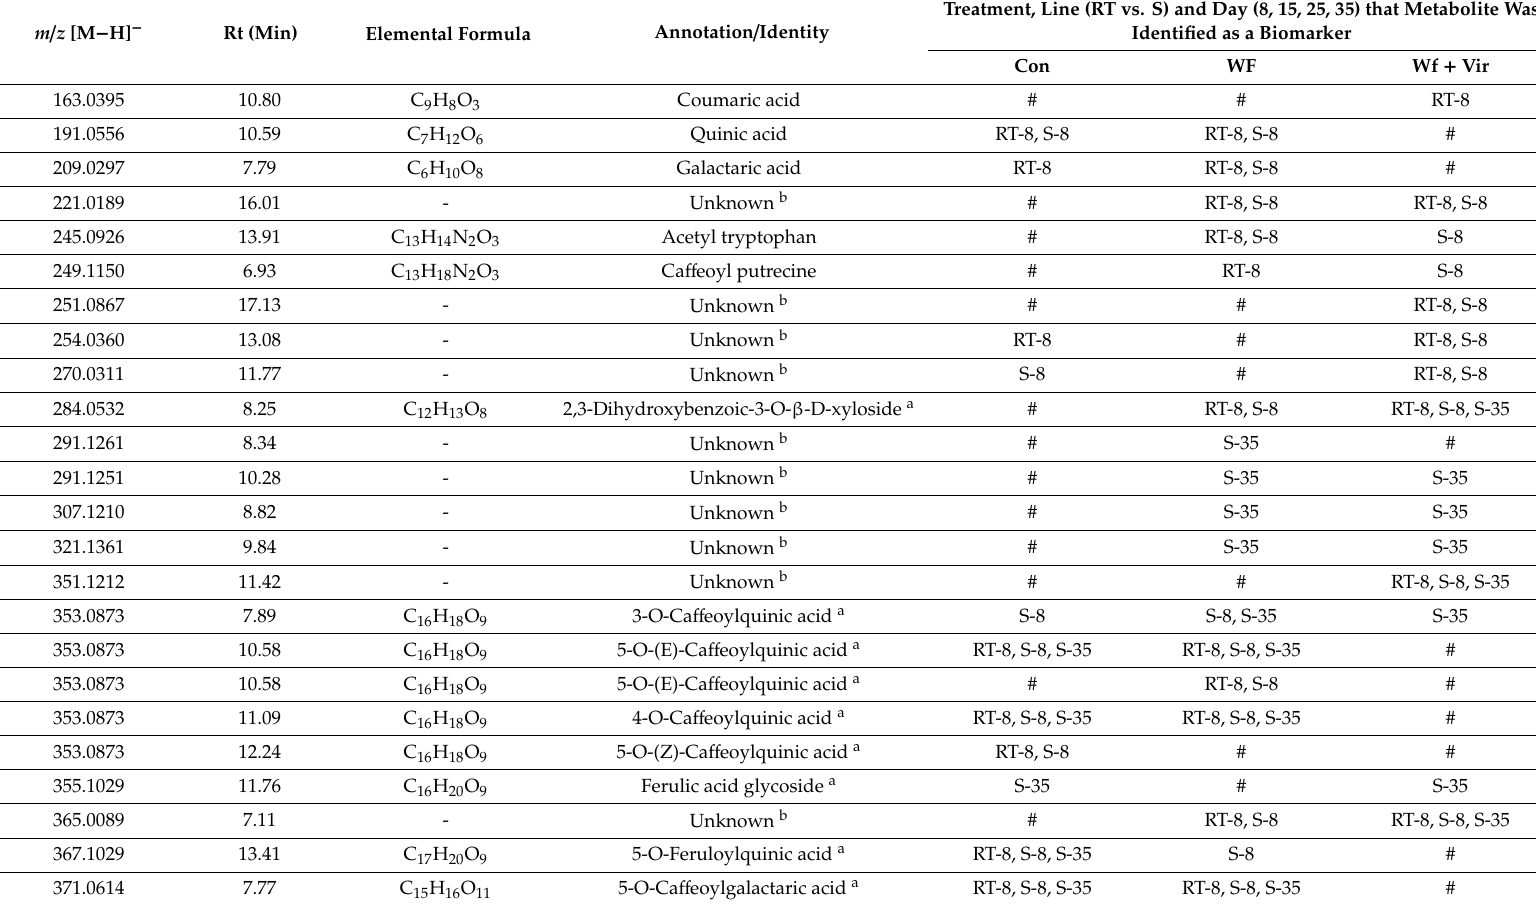
Table 1. Probable identities ( m / z , retention times and elemental composition) of the annotated metabolites / biomarkers lying outside the − 0.1 to 0.1 range on both the x and the y axes of the loadings plots for RT (Figure 4) and S (Figure 5) of control ( Con ) versus whitefly ( WF ) and versus viruliferous whitefly ( WF + Vir ). The table also shows in which treatment group, of which line on which day each annotated metabolite was identified as a signatory